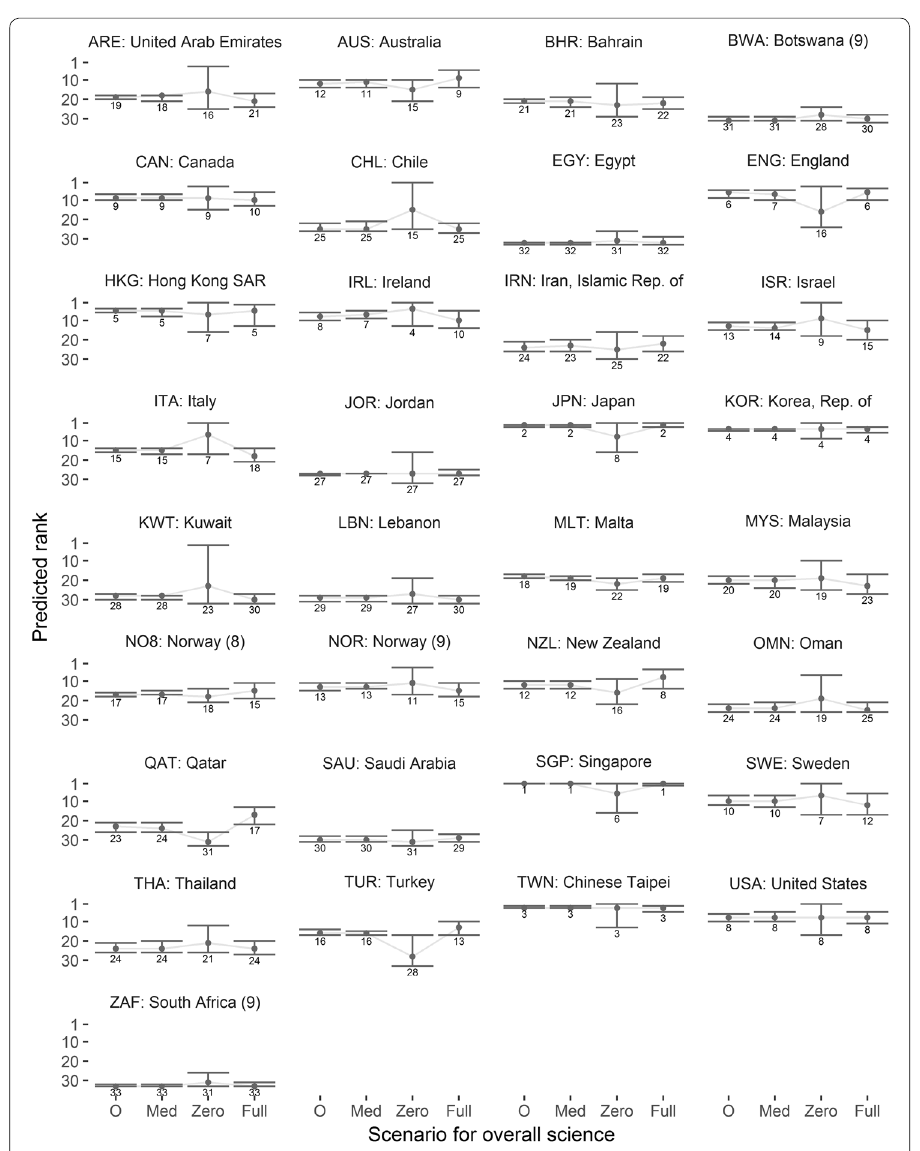
Fig. 5 Predicted rank across TICS scenarios. O have implemented the country-specific median, the least possible, or most possible level of TICS within the country,